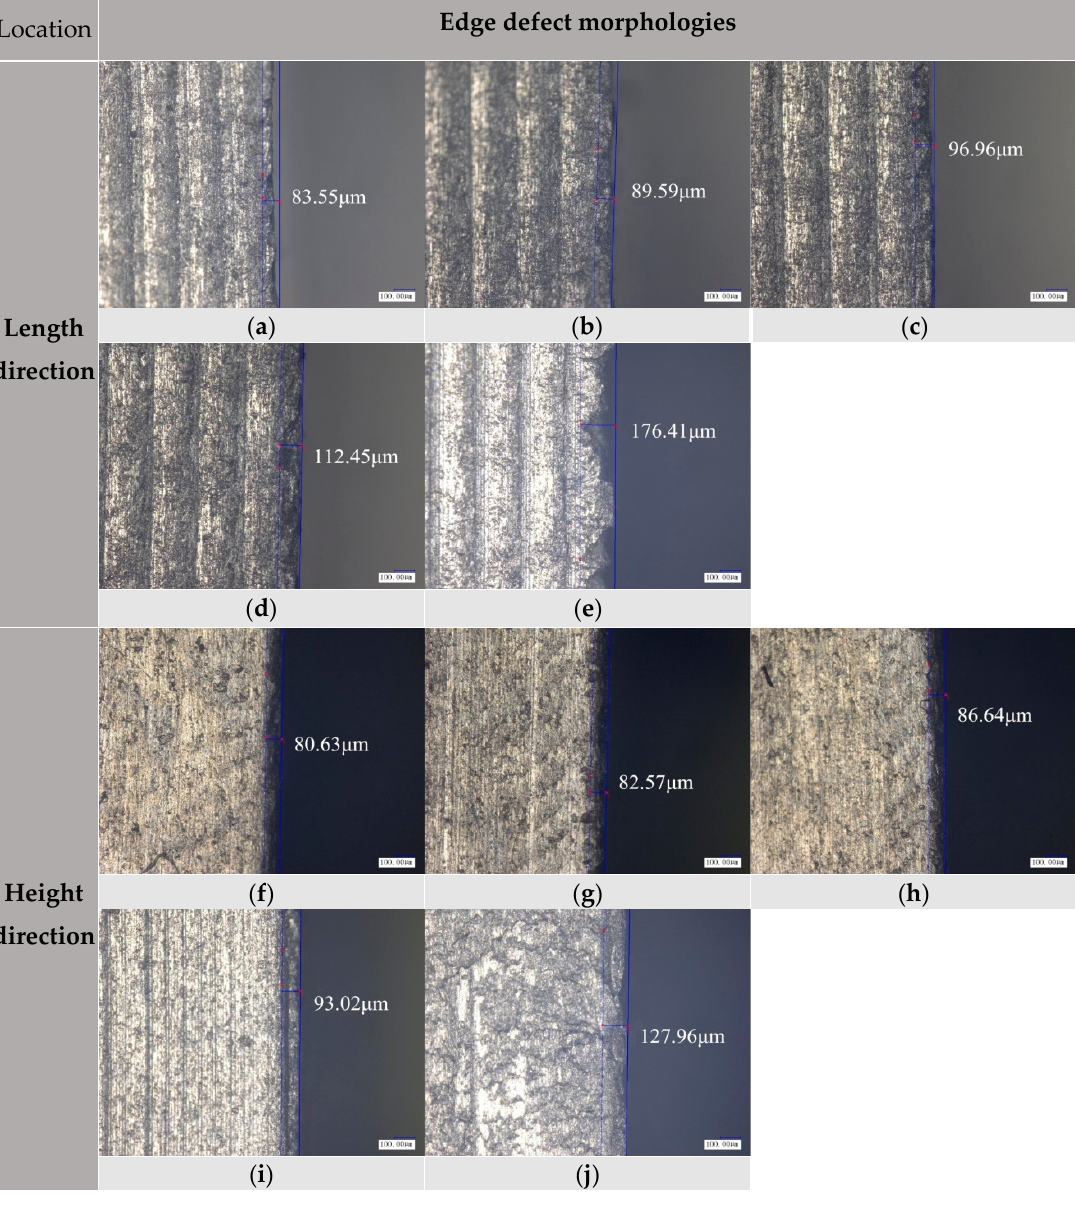
Figure 5. Edge morphology on the exit surface, at the depth of cut of: ( a , f ) 1 mm, ( b , g ) 1.5 mm, ( c , h ) 2 mm, ( d , i ) 2.5 mm, ( e , j ) 3 mm.